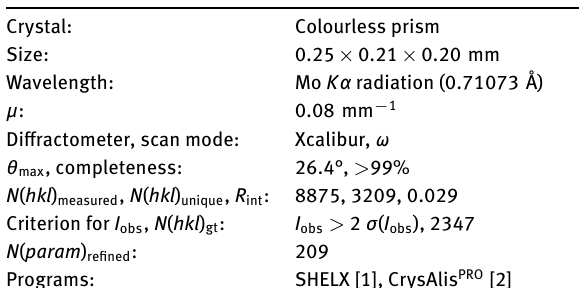
Table 1: Data collection and handling.